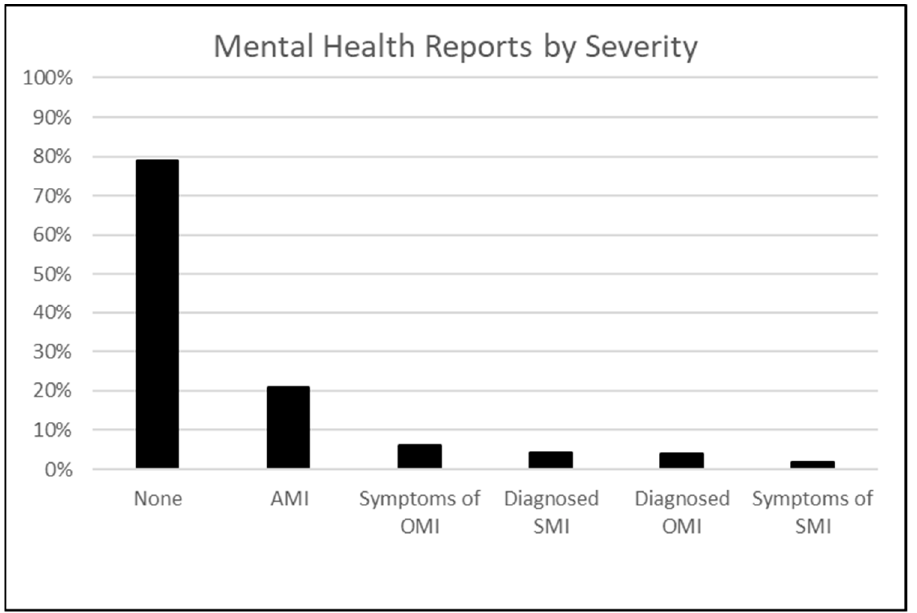
Figure 1. By Authors. AMI = Any Mental Illness; SMI = Serious Mental Illness; OMI = Other Mental Illness (AMI but not SMI).